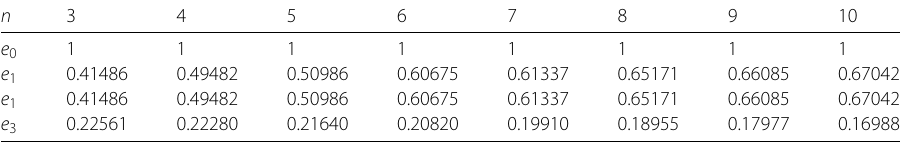
Table 2 Eigenvalues of trigonometric (i.e., μ (cid:2) +1 = cos(2 π /5 × 2 (cid:2) +1 )) subdivision matrix with valence n